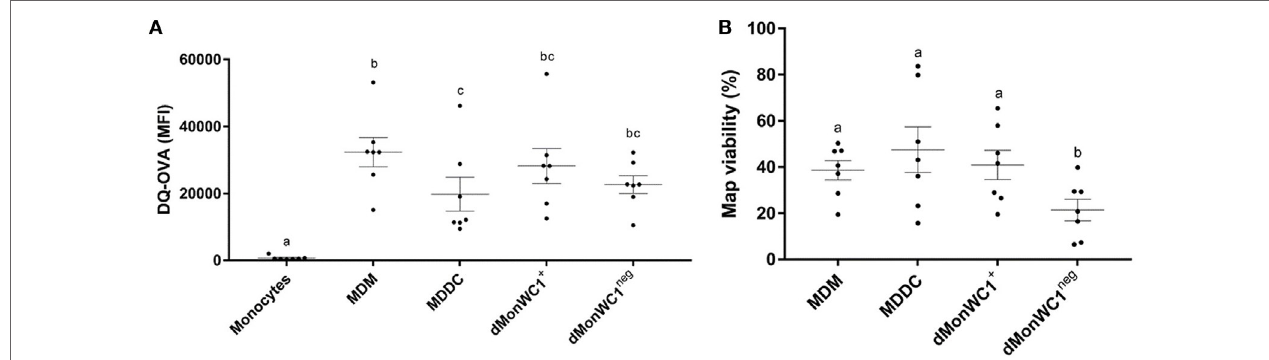
FigUre 3 | cells from the MPs have a heterogeneous phagocytic capacity and the presence of Wc1 neg γδ T lymphocytes increase the ability of differentiated monocytes to alter Mycobacterium avium subspecies paratuberculosis ( Map ) viability . (a) Monocyte-derived macrophages (MDMs) had the highest phagocytic capacity, followed by monocyte-derived dendritic cell (MDDC). dMonWC1 + and dMonWC1 neg showed an intermediate phagocytic activity between MDMs and MDDC. (B) Map viability measured by flow cytometry after 48 h of infection of MDMs, MDDC, dMonWC1 + , and dMonWC1 neg . The viability of Map harvested from dMonWC1 neg was significantly lower compared to MDMs, MDDC, and dMonWC1 + . Results are individual animal data points and means ± SEM of seven animals. Different letters indicate statistically significant difference ( p <